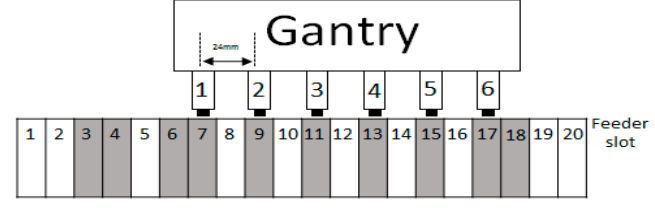
Figure 2. One pick sequence.